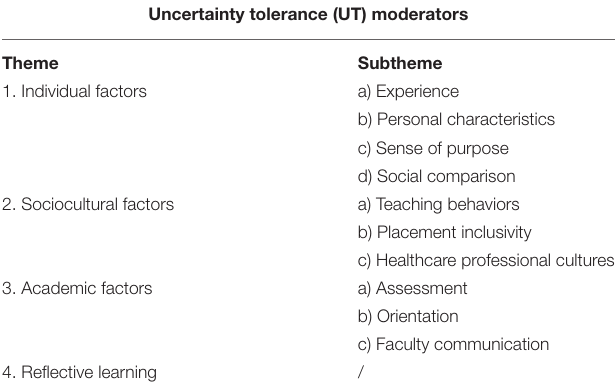
TABLE 3 | Overview of the thematic structure of